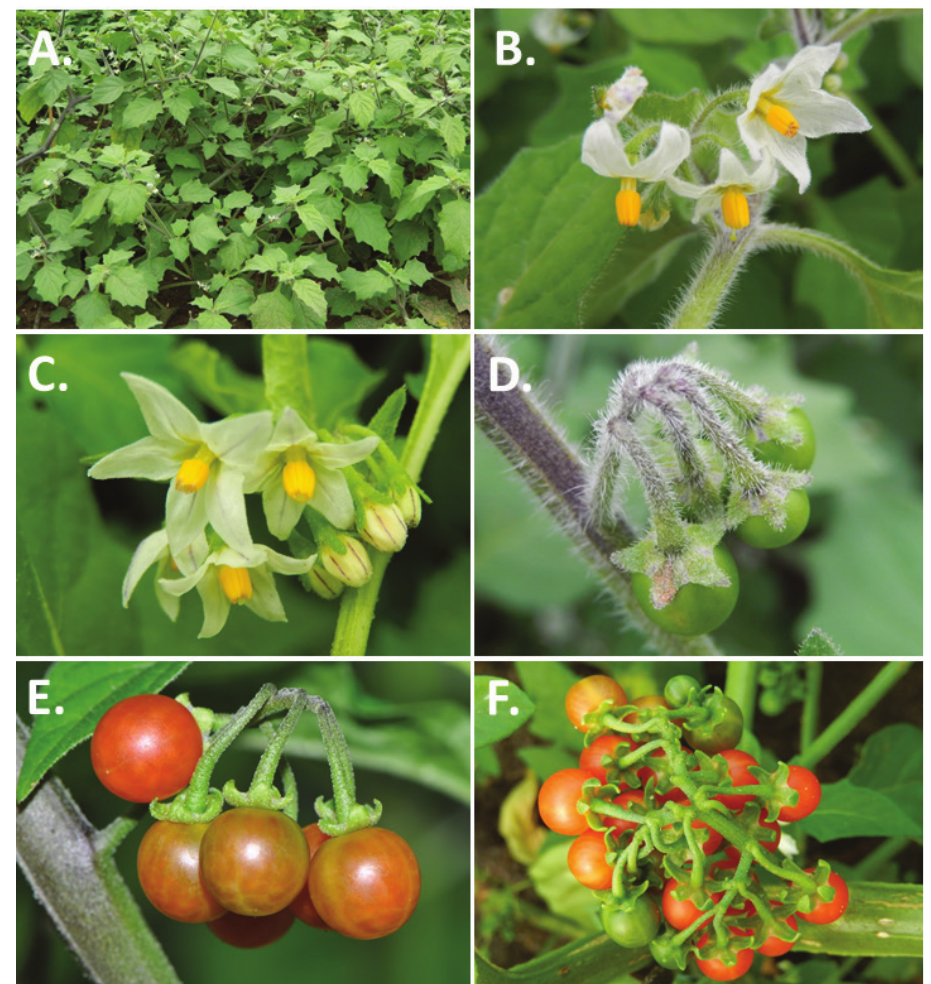
Figure 55. Solanum villosum Mill. A Habit B inflorescence in densely pubescent plant C flowers and buds D immature infructescence E fully mature fruits F fully mature fruits showing reflexed ca- lyx lobes ( A Nijmegen accession 884750135 B Nijmegen accession 914750047 C Nijmegen accession A34750061 D Nijmegen accession A34750043 E Nijmegen accession A14750048 F Nijmegen accession A34750038). Photos by T. Särkinen and G. van der Weerden (previously published in “PhytoKeys 106”).